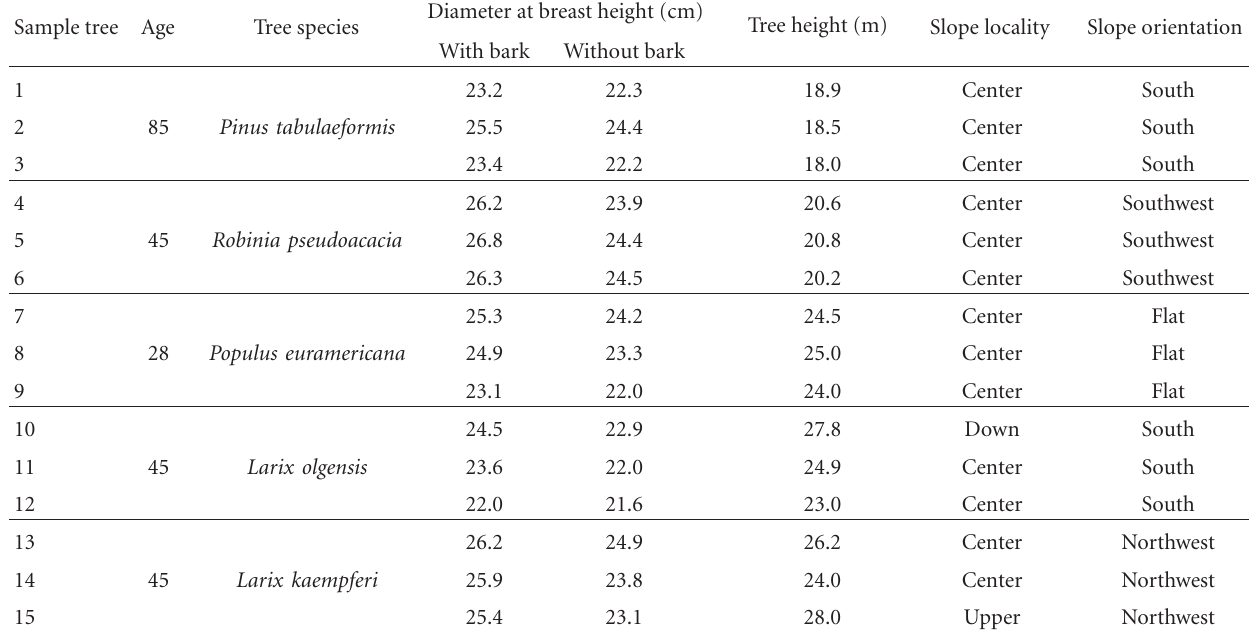
Table 1: Diameters at breast height and heights of sample